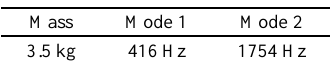
Table 3 Mass and frequencies of the first two